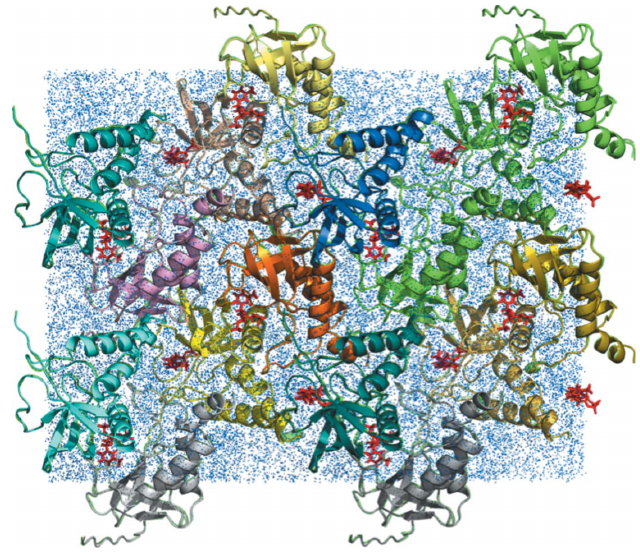
Figure 1 Staphylococcal nuclease supercell model. Eight unit cells containing four protein molecules each are arranged in a 2 (cid:2) 2 (cid:2) 2 layout. Protein chains are rendered as cartoons. The pdTP ligand is rendered as red sticks. Water atoms are indicated using speck-like blue spheres. The image was rendered using PyMOL